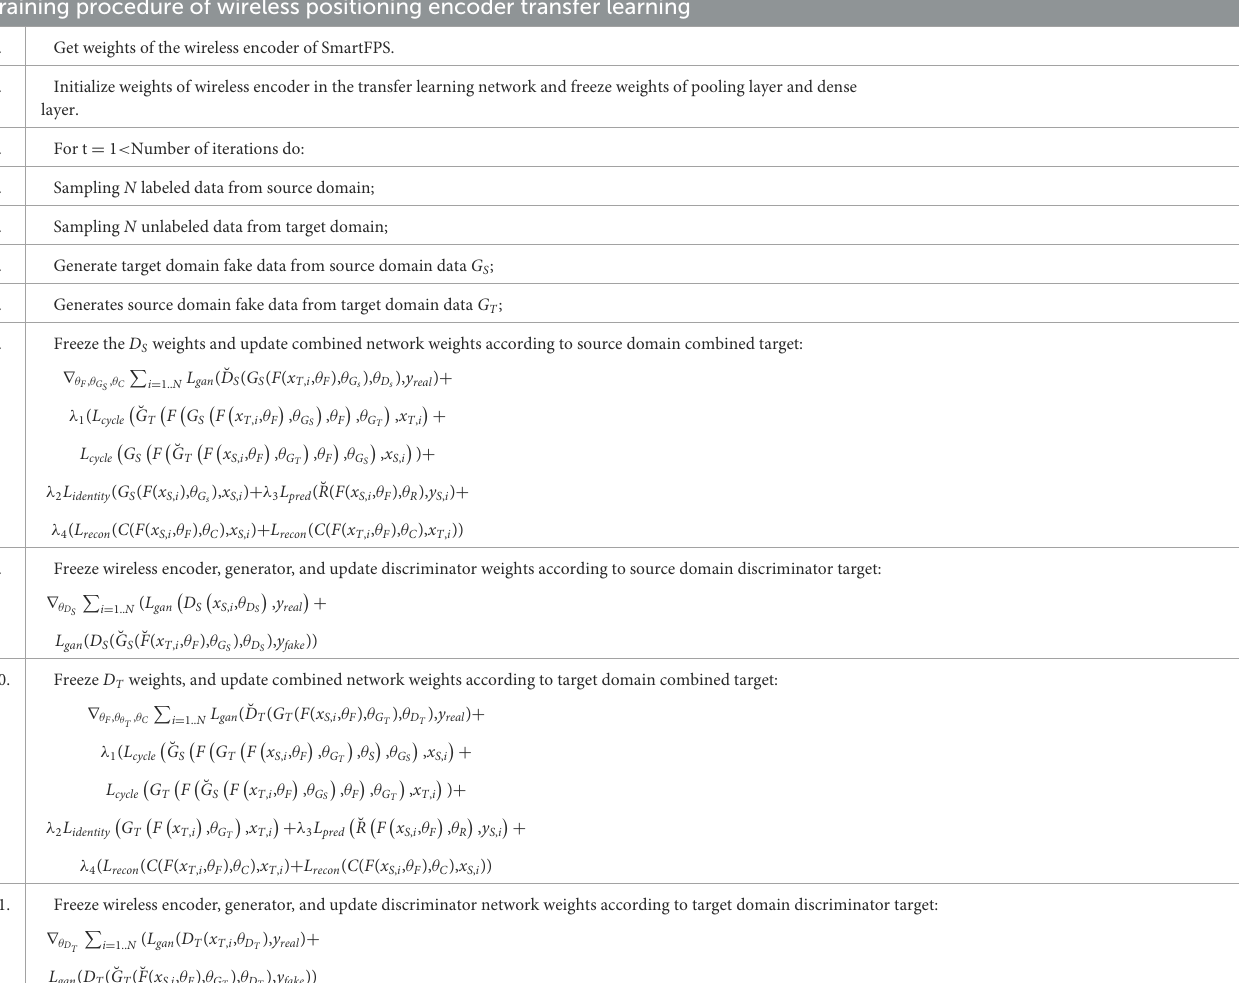
TABLE 1 Algorithm 1: Training procedure of wireless positioning encoder transfer learning. Training procedure of wireless positioning encoder transfer learning